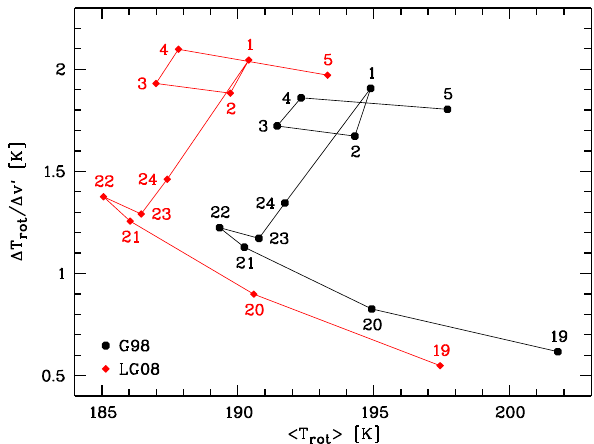
Figure 9. T rot (v (cid:48) ) as a function of v (cid:48) for different local time periods. Data points for the same period are connected by lines of a fixed type and colour (see legend). All data points are based on the G98 line parameters. The errors of the plotted mean values are of the order of 1K.